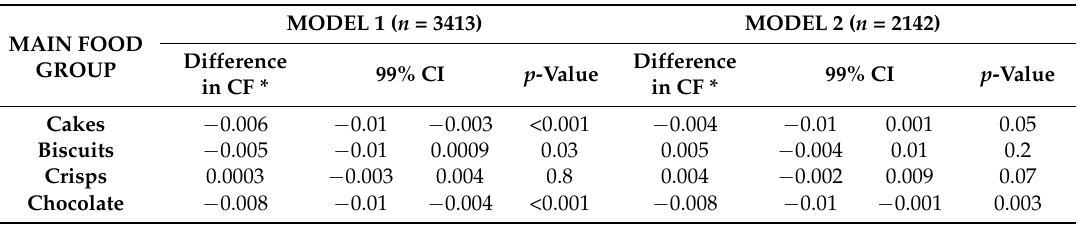
Table 4. Association between consumption frequency (CF) of energy dense food groups in adults aged 19–64 years and BMI in the NDNS. Model 1 adjusted for age and sex. Model 2 adjusted for age and sex after excluding